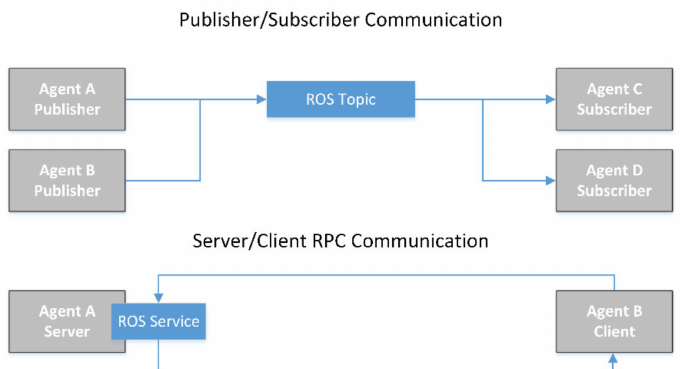
Figure 6. Detail of the two di ff erent communications schemas supported by ROS. Top: data are published into topics by publishers (one or more), where any amount of subscribers will receive it. Bottom: under the RPC (remote procedure call) paradigm, each communication instance is initiated by a client who sends a request to a server and receives a response once the request has been processed. Under an ROS framework, this communication (with slight variants) can be implemented either as an ROS service or as an ROS